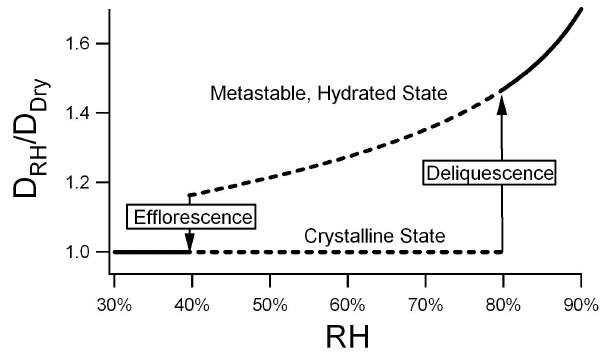
Fig. 1. Idealized ammonium sulfate growth